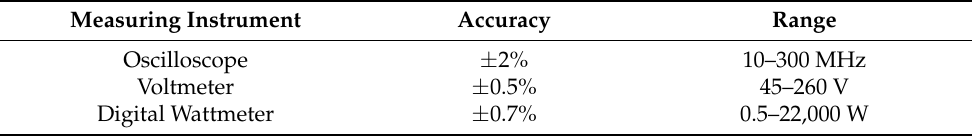
Table 1. Technical specifications of the instrumentation used in the experimental